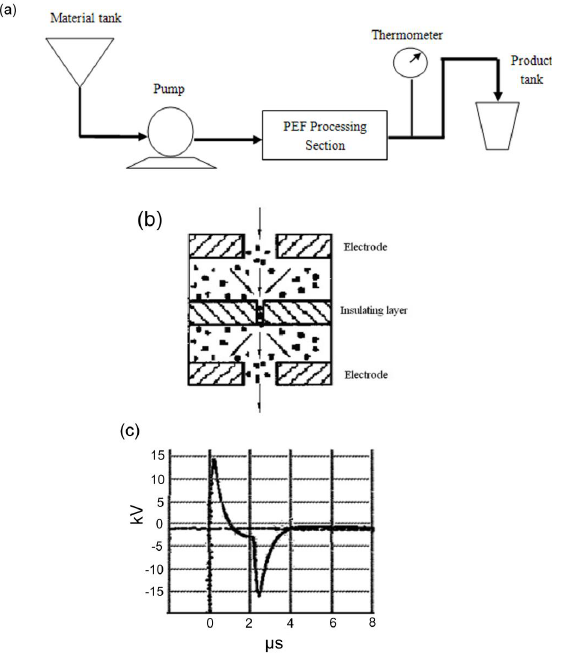
Figure 2: (a) Schematic of high-intensity pulsed electric fields processing apparatus (b) Structure diagram of PEF treatment chamber (c) Form of pulsed